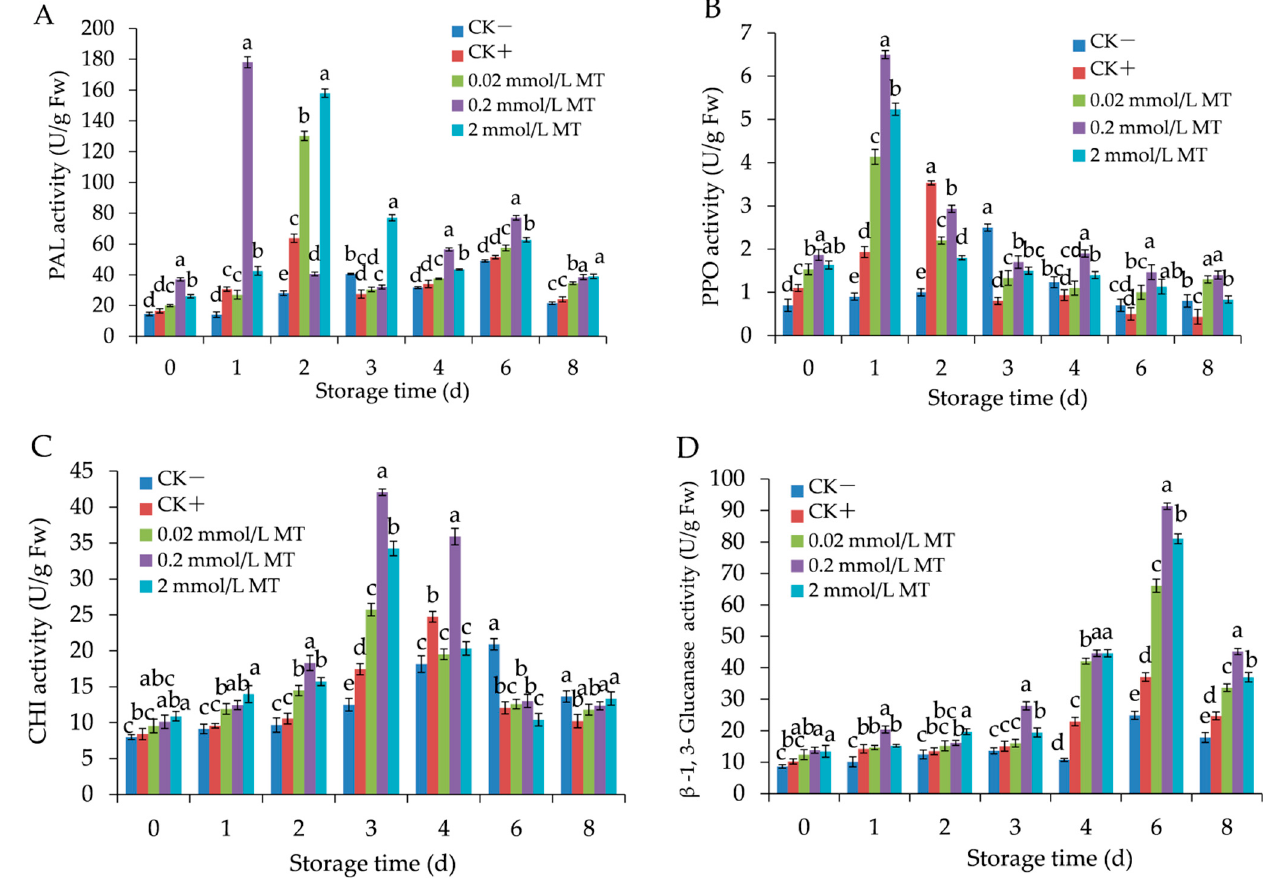
Figure 7. Effect of melatonin treatment on the activities of phenylalanine ammonia-lyase ( A ), polyphenol oxidase ( B ), chitinase ( C ), and β -1,3-glucanase ( D ) in grape berries. Data represent means ± S.E. ( n = 3). Duncan’s multiple range test was used to analyse significant differences in data, and letters above the bars represent differences at p < 0.05.